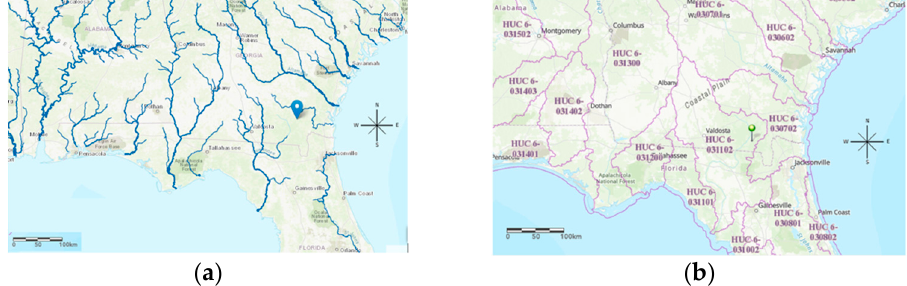
Figure 2. ( a ) Major rivers around the Okefenokee Swamp (blue pin). Map created using Model My Watershed program with Continental US Medium Resolution Stream Network overlay; ( b ) HUC-6 watersheds around the Okefenokee Swamp (blue pin). Map created with ArcGIS, USGS Watershed Overlay.